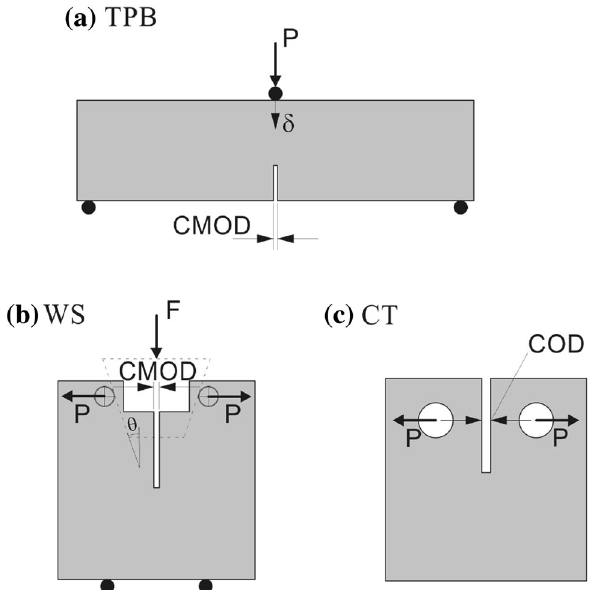
Fig. 2 Schematic representation of several usual tests for measuring the specific fracture energy of concrete. a Three-point bending, b wedge splitting and c compact tension